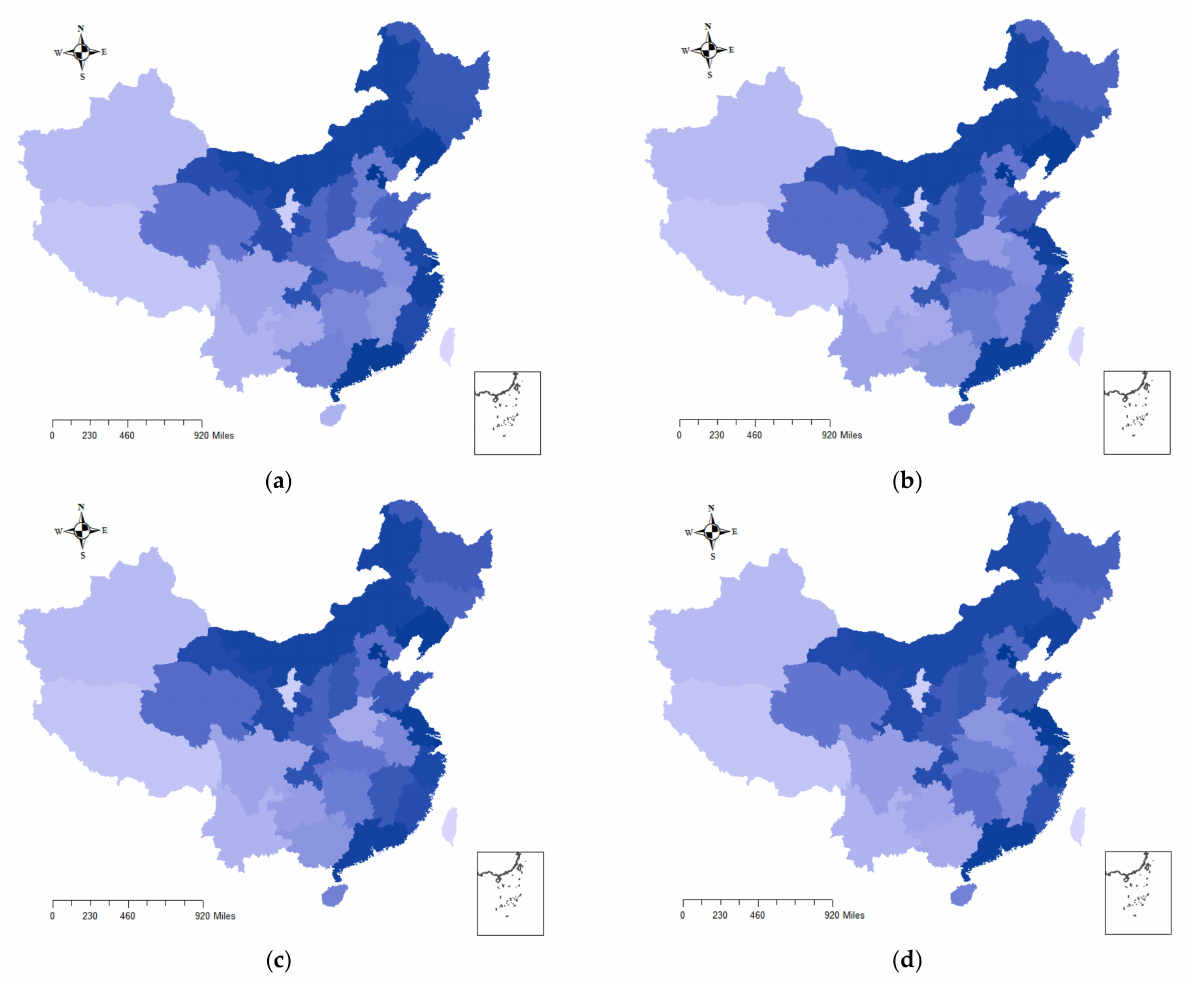
Figure 1. ( a ) 2010; ( b ) 2013; ( c ) 2016; ( d ) 2019. China’s Gini coefficient rankings by region in 2010, 2013, 2016 and 2019. Note: Since regional Gini coefficients have minor differences in value, the map is drawn by order. The darker that the color is, the greater that the Gini coefficient of regional residents’ income